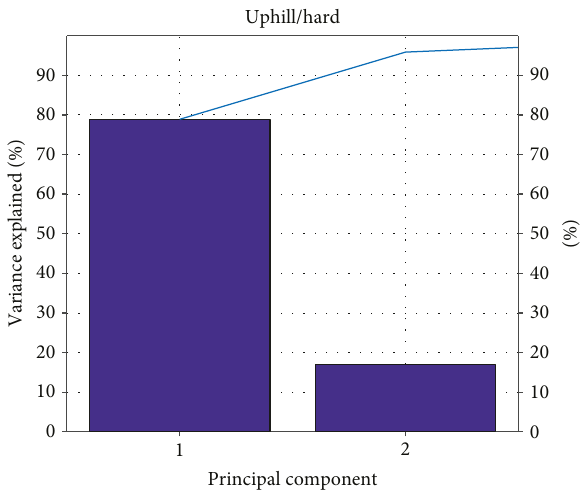
Figure 9: The relationship between the principal component and the variance explained for U/H.